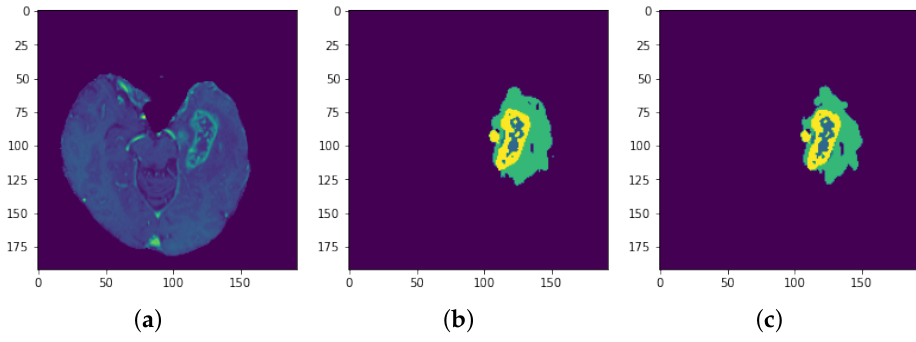
Figure 30. Results: Slice 3: ( a ) Slice ( b ) Predicted result ( c ) Actual result.